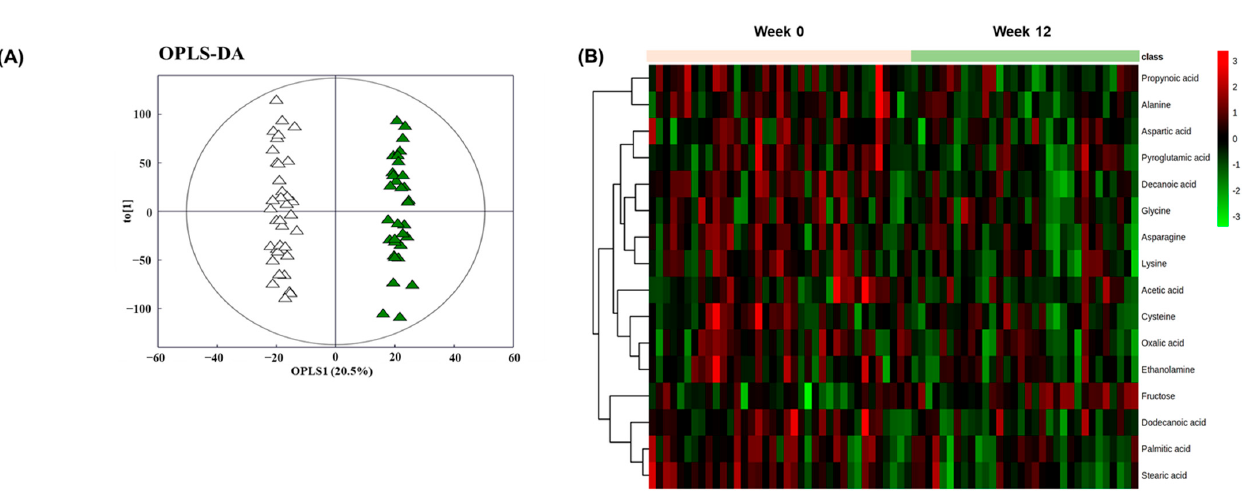
Table 3. Liver cell damage markers at the baseline and endpoint in the placebo and BSE groups.